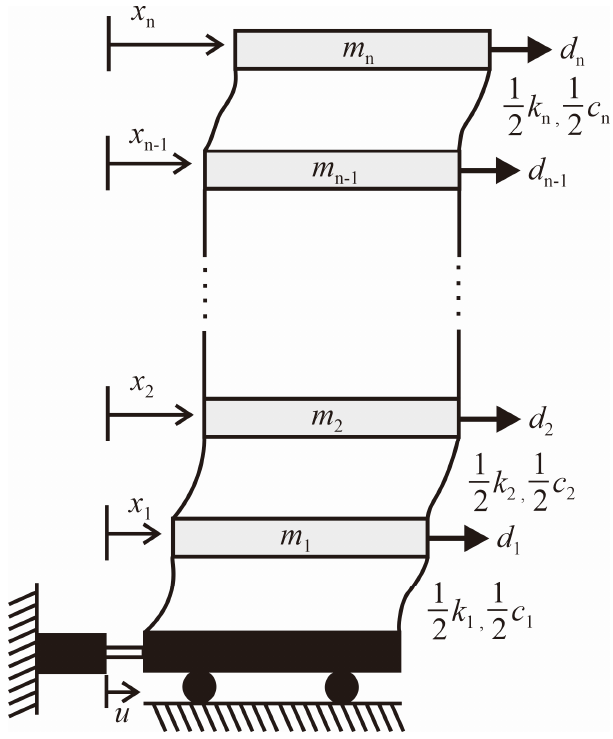
Figure 12. Multi-degree-of-freedom model.